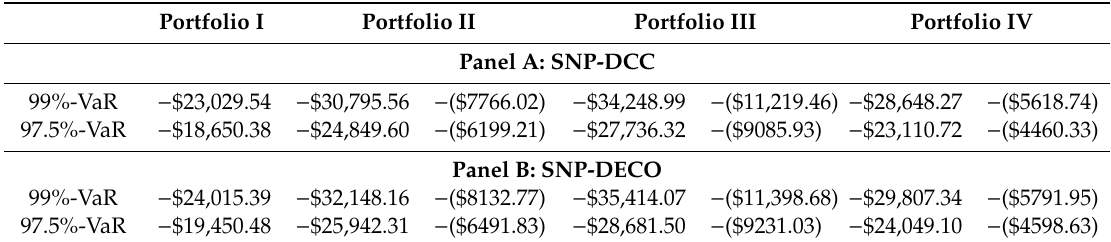
Table 7. Portfolio Incremental VaR for the SNP-DCC and SNP-DECO Models.